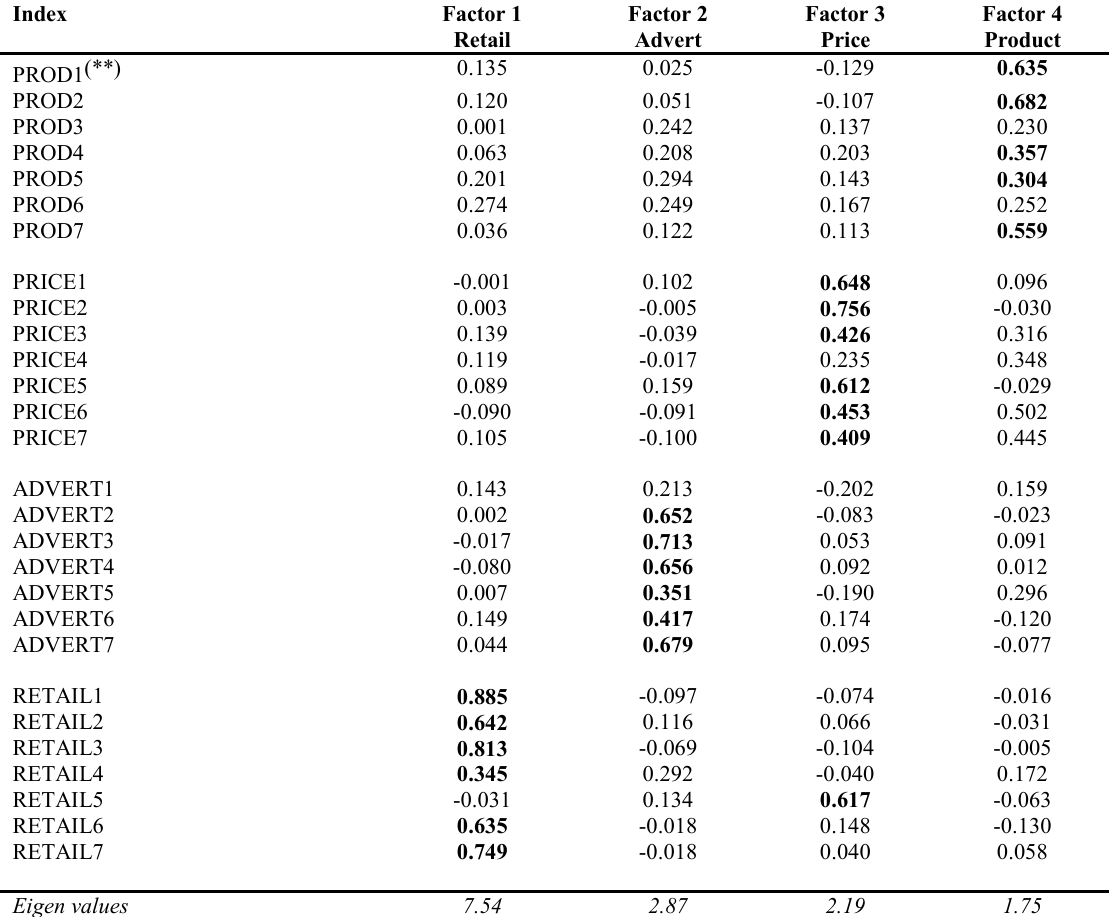
Table 4: Rotated factor loadings